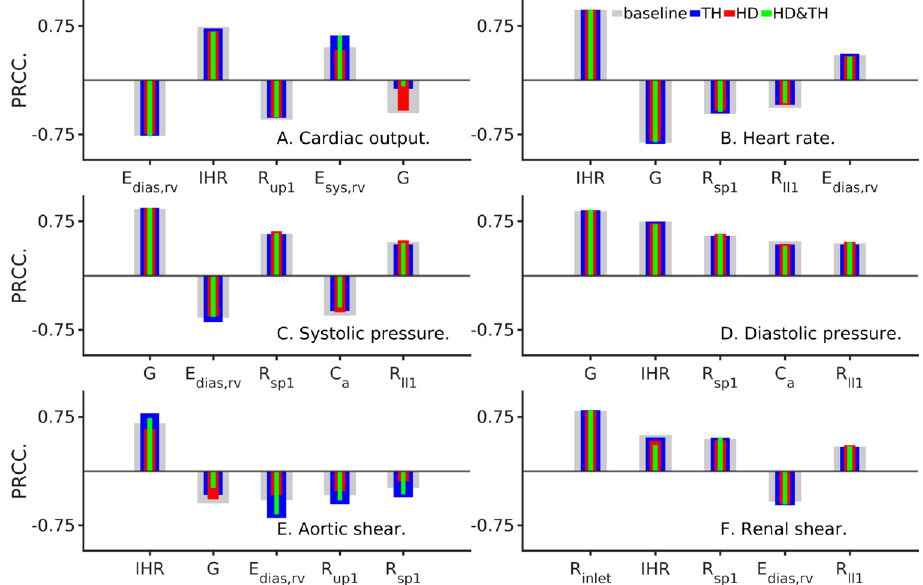
Figure 11. Sensitivity of clinically relevant model outputs to parameters. In all panels, E dias,rv represents diastolic right ventricle elastance; E sys,rv represents systolic right ventricle elastance; IHR represents intrinsic heart rate; R up1 represents upper body resistance; G represents baroreflex regulatory parameter; R sp1 represents splanchnic resistance; R ll1 represents legs resistance; C a represents aorta compliance; R inlet represents kidney inlet resistance.